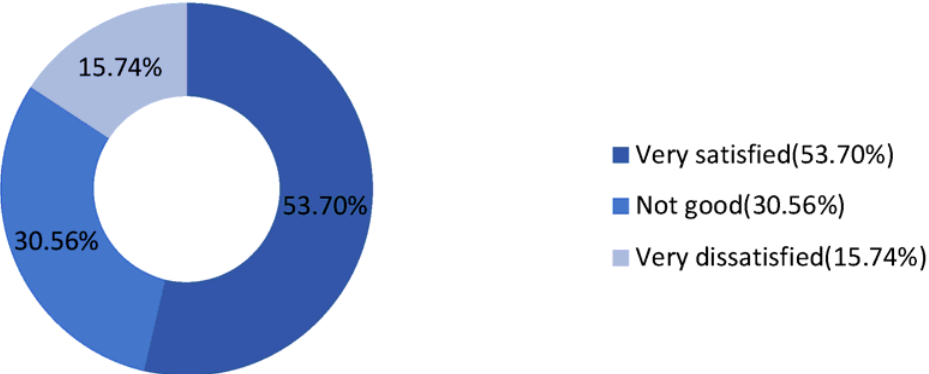
Figure 4. Villagers’ satisfaction with protection of features. The original question was “Are you satisfied with the current protection condition of Lingquan Village?”.